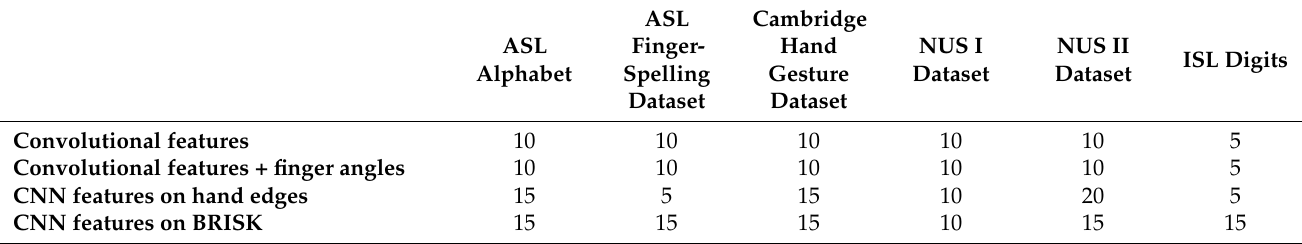
Table 9. Ideal number of PCA components.